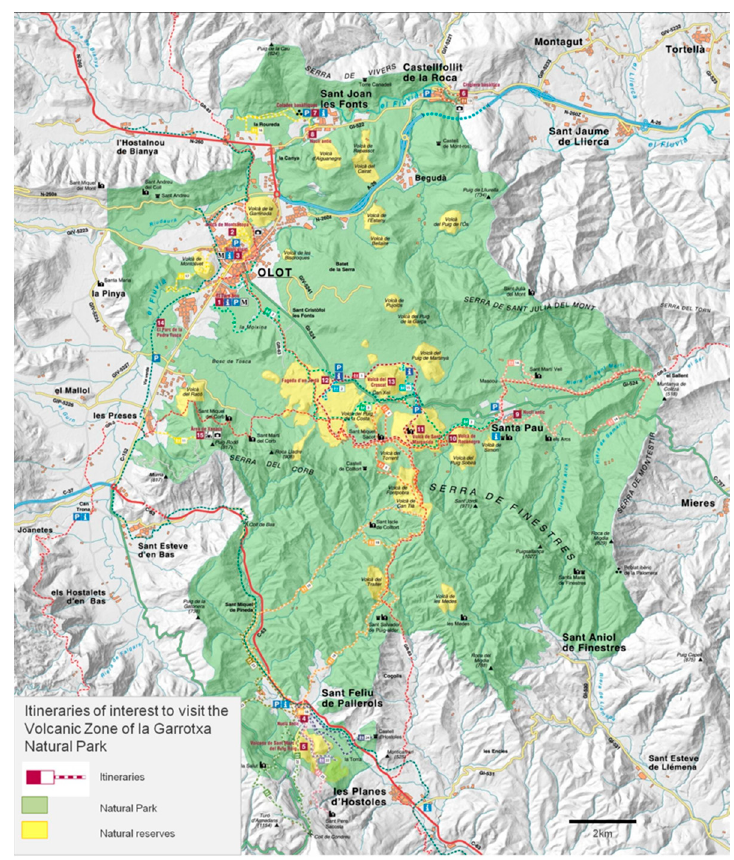
Figure 6. Itineraries scheme of the natural park of La Garrotza Volcanic Zone.